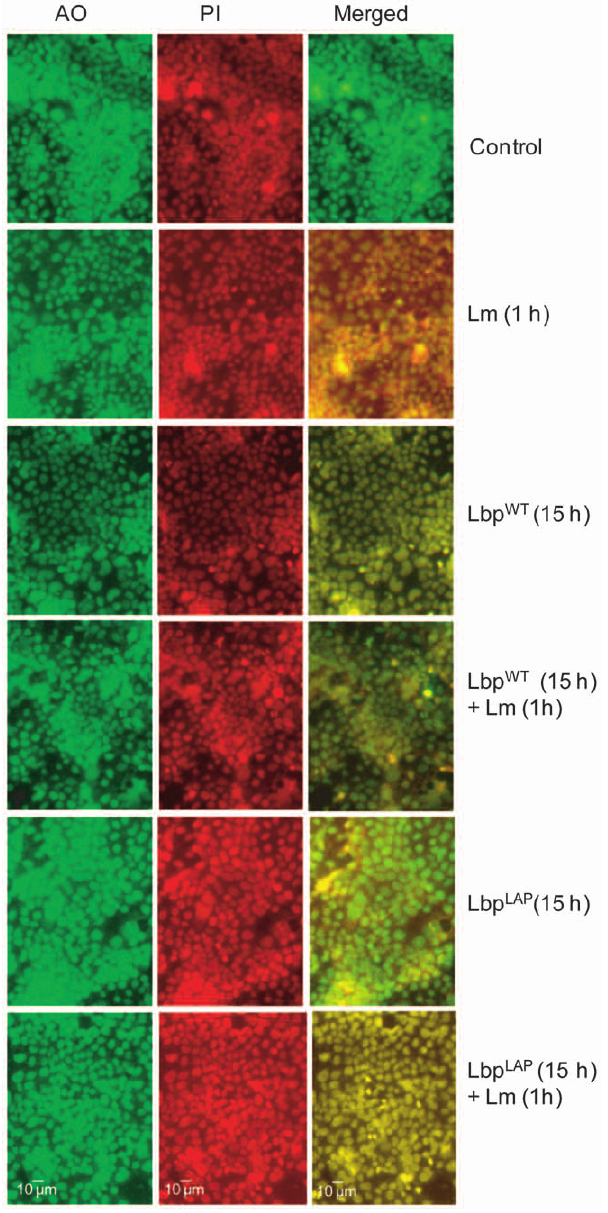
Figure 7. Microscopic analysis of protection of Caco-2 cells from Listeriamonocytogenes (Lm)-mediated damage by recom- binant Lb.paracasei (Lbp LAP ). Caco-2 cells pre-exposed to wild type Lb. paracasei (Lbp WT ) or Lbp LAP for 15 h before infection with Lm for 1 h were stained with a mixture of acridine orange (green) for live cells and propidium iodide (red) for dead cells. Orange-red cells in the merged picture indicate dead or dying cells. Bar, 10 m m.